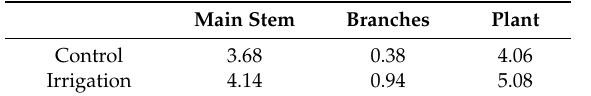
Table 1. Seed yield of yellow lupine [g / plant] harvested from the main stems, branches and whole control (not irrigated) and irrigated plants.